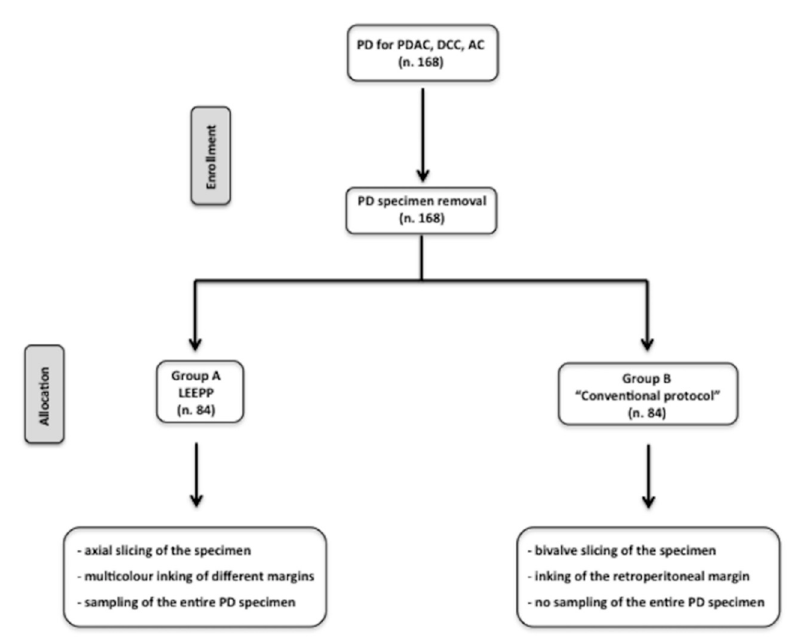
Figure 1. PRISMA flow-chart showing randomization process for the pathological evaluation of PD specimen: Group A (LEEP) and Group B (conventional protocol).